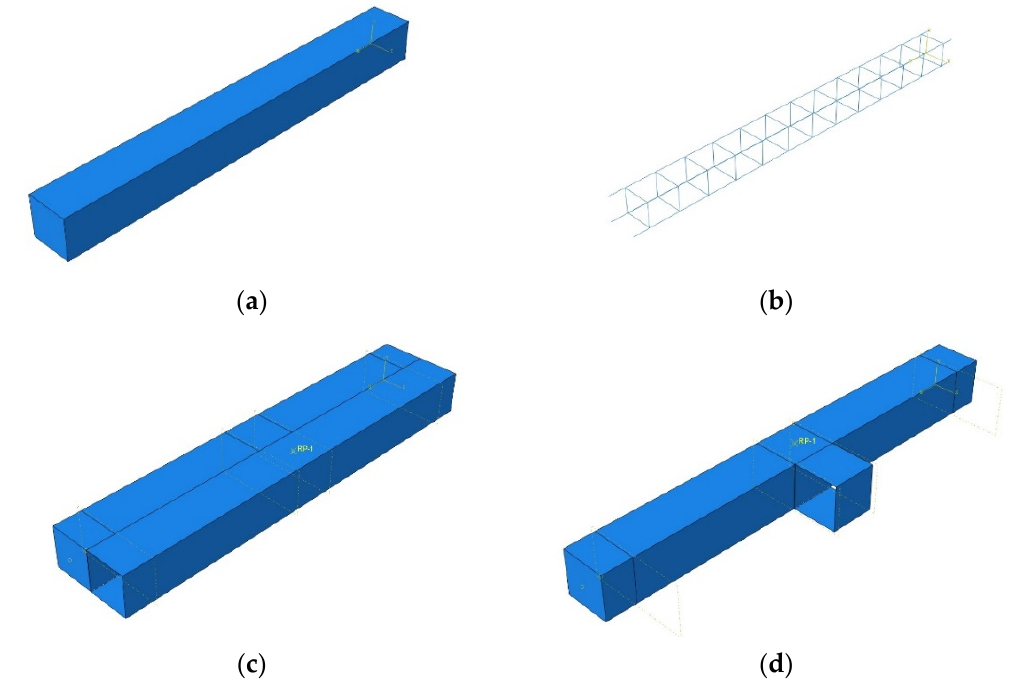
Figure 5. Details of the finite element model for RC beams. ( a ) Conventional beam. ( b ) Reinforcement details. ( c ) Beam with carbon fiber mesh jacketing for the total length. ( d ) Beam with carbon fiber mesh at plastic hinge length.